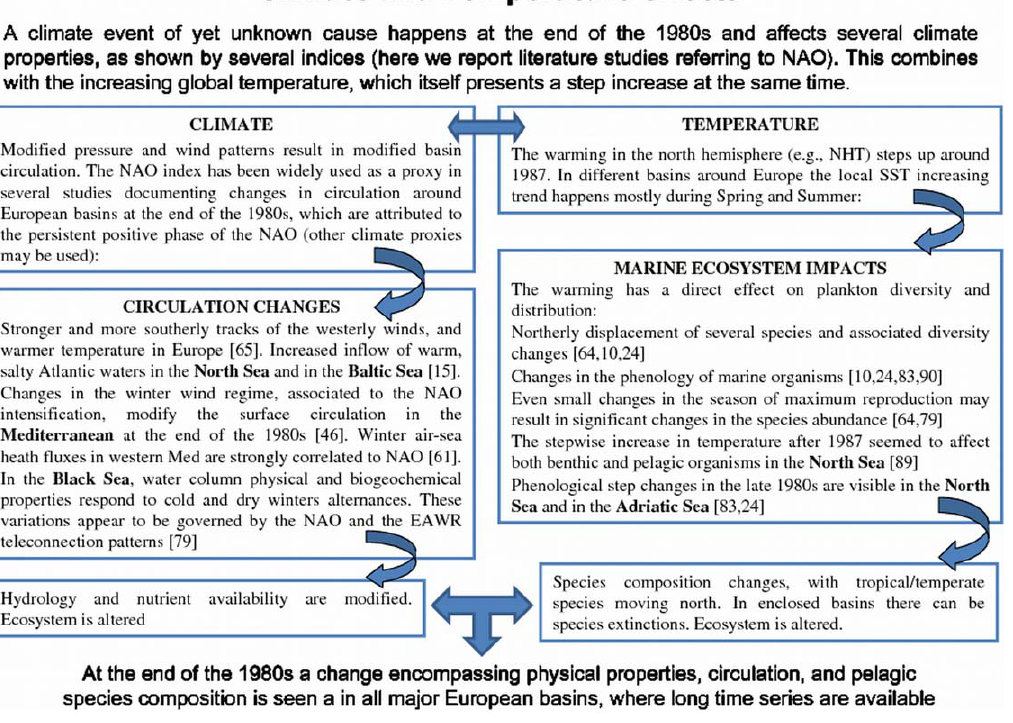
Figure 7. Simplified scheme showing different impacts of atmospheric patterns (as exemplified by the NAO index) and global temperature (as exemplified by the NHT index) on marine ecosystems. The numbers in square brackets indicate supporting references.